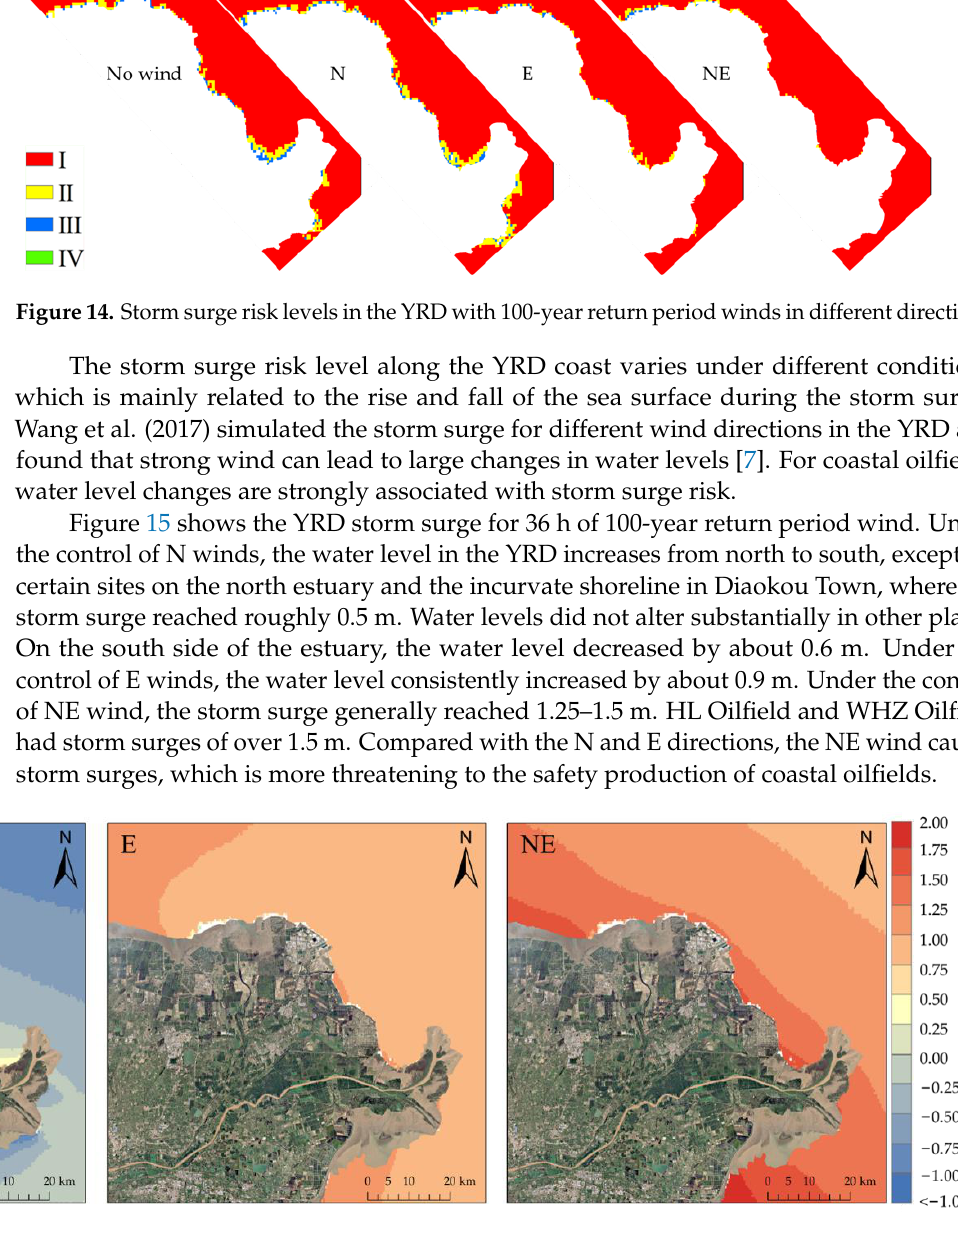
Figure 13. Coastal oilfields in the YRD, including Feiyantan (FYT), Chengdao (CD), Zhuangxi (ZX), Wuhaozhuang (WHZ), Gudong (GD), Hongliu (HL), and Xintan (XT) oilfields.